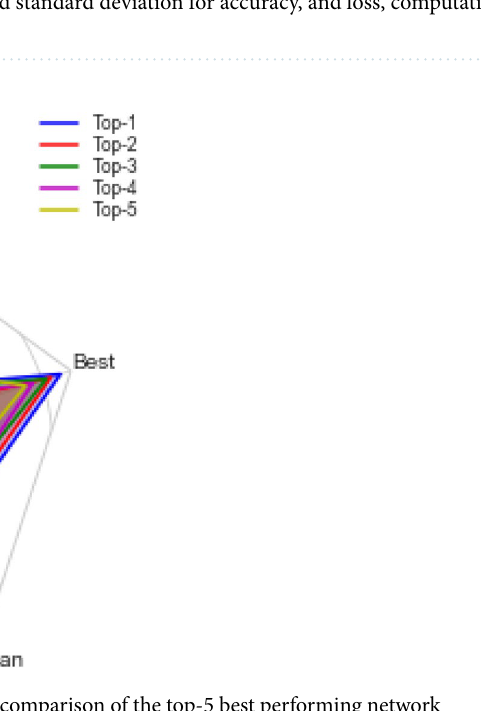
Figure 9. A radar plot showing the performance comparison of the top-5 best performing network architectures from EOSA-NAS algorithm based on mean, median, worst, and best accuracy values.